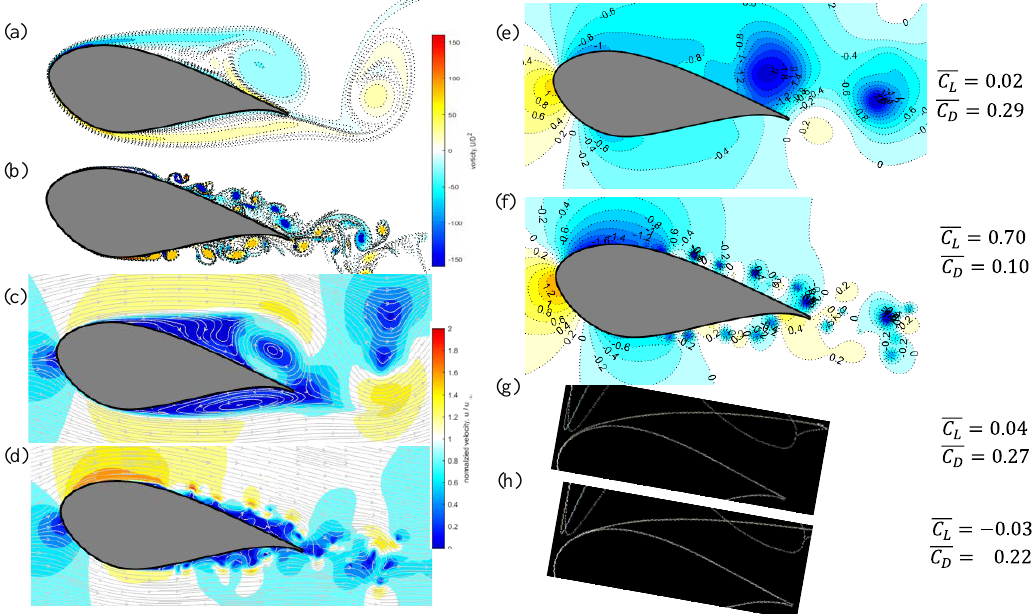
12d). By comparing the pressure fields in Figures 11e,f and 12e,f, it can be seen that the smaller mean drag as compared to the low Reynolds number pressure fields.